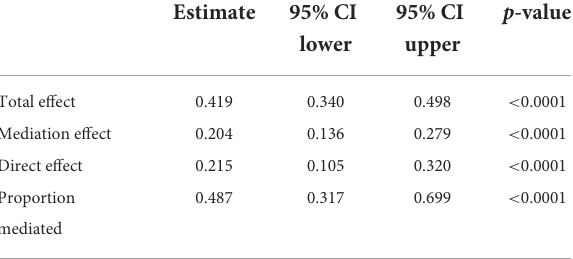
TABLE 3 Mediation analysis in generalized additive model